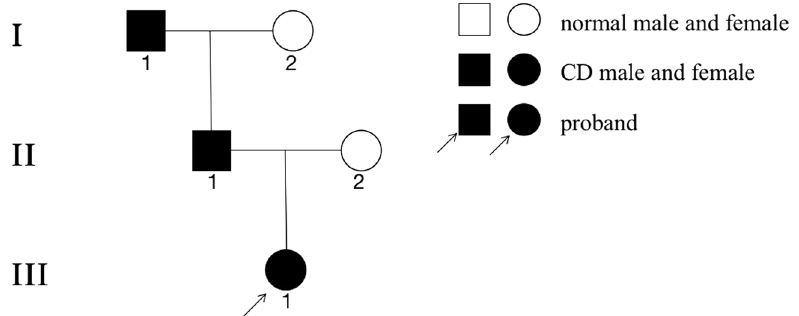
Figure 1: Pedigree of the family. The proband ( III 1 ) is indicated by the